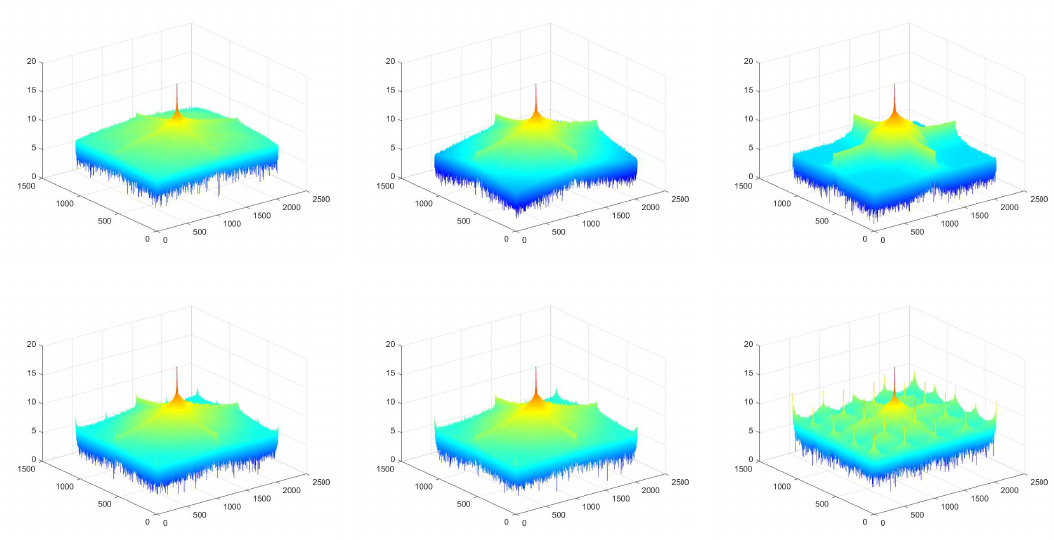
Figure 9. The power spectra of the second image in Figure 7: HR, EDSR, ZSSR, UMGSR with MSE loss, and UMGSR with total loss. Smooth edge of spectra reflects more colorful details and sharp fault means the lack of some color range. Even though abundant power spectra does not mean accurate, it indeed prove more vivid details in the image. As a result, our model can generate dramatic features than accurate pursuing models(EDSR,